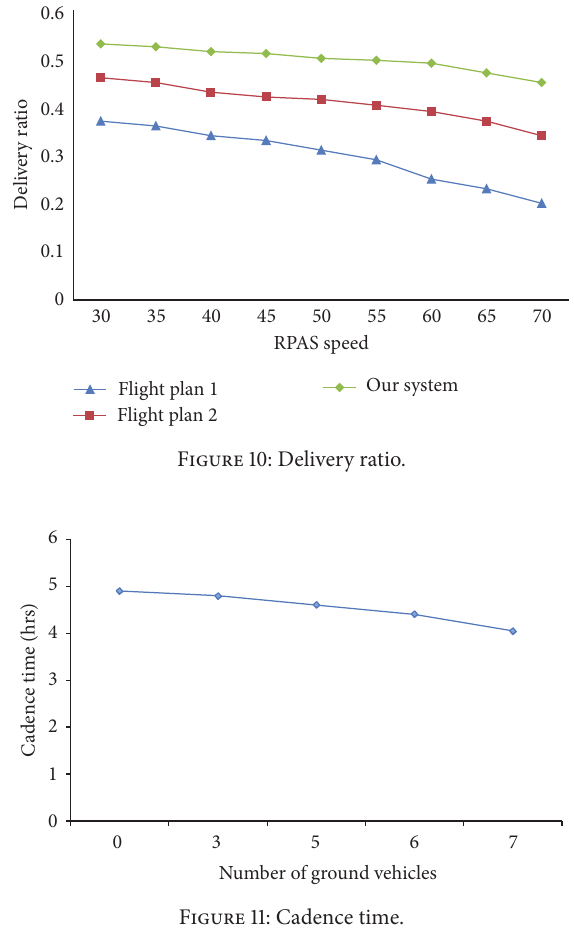
Figure 11: Cadence time.